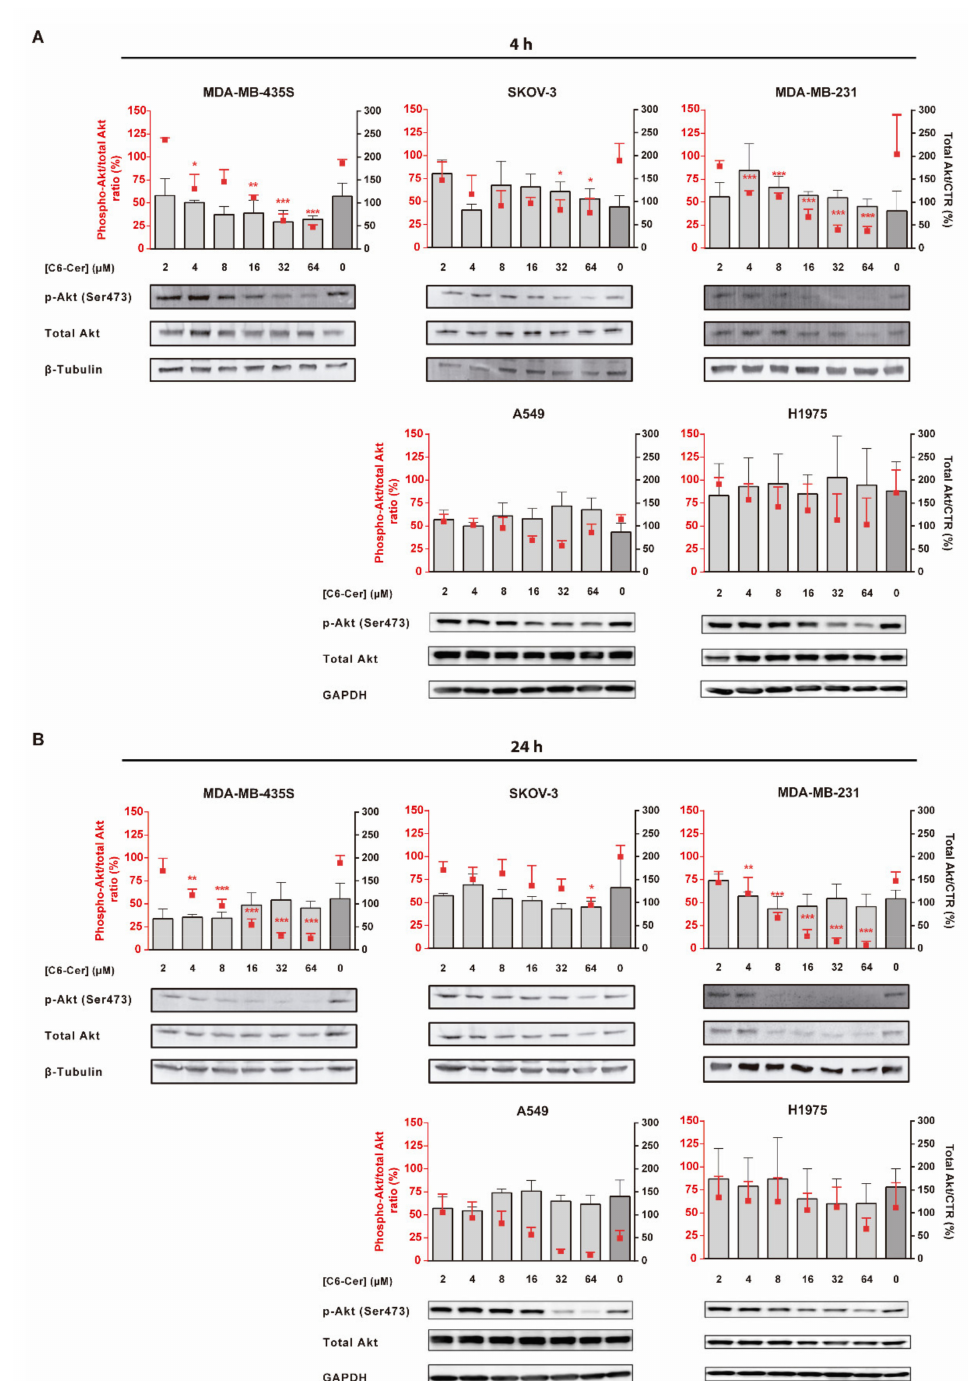
Figure 6. Evaluation of the modulation of p-Akt protein level by F3 peptide-targeted C6-ceramide liposomes in cancer cell lines of diverse histological origin. MDA-MB-435S, SKOV-3, MDA-MB-231, A549 and H1975 cells were incubated with the indicated concentration of C6-ceramide encapsulated in F3 peptide-targeted liposomes ([F3]L-C 6 ) for ( A ) 4 h or ( B ) 24 h at 37 ◦ C. Extracted cellular proteins were analyzed by immunoblotting and band signals for p-Akt (Ser473) and Akt were quantified through densitometry imaging, and the p-Akt/total Akt ratio (red squares) and total Akt/Control (bars) for each condition were calculated. Equal amounts of protein were loaded in each lane. Data represent the mean ± SEM ( n = 3; one-way ANOVA with Dunnett’s post-test; * p < 0.05, ** p < 0.01 and *** p < 0.001). Whole Western Blot images can be found in Figure